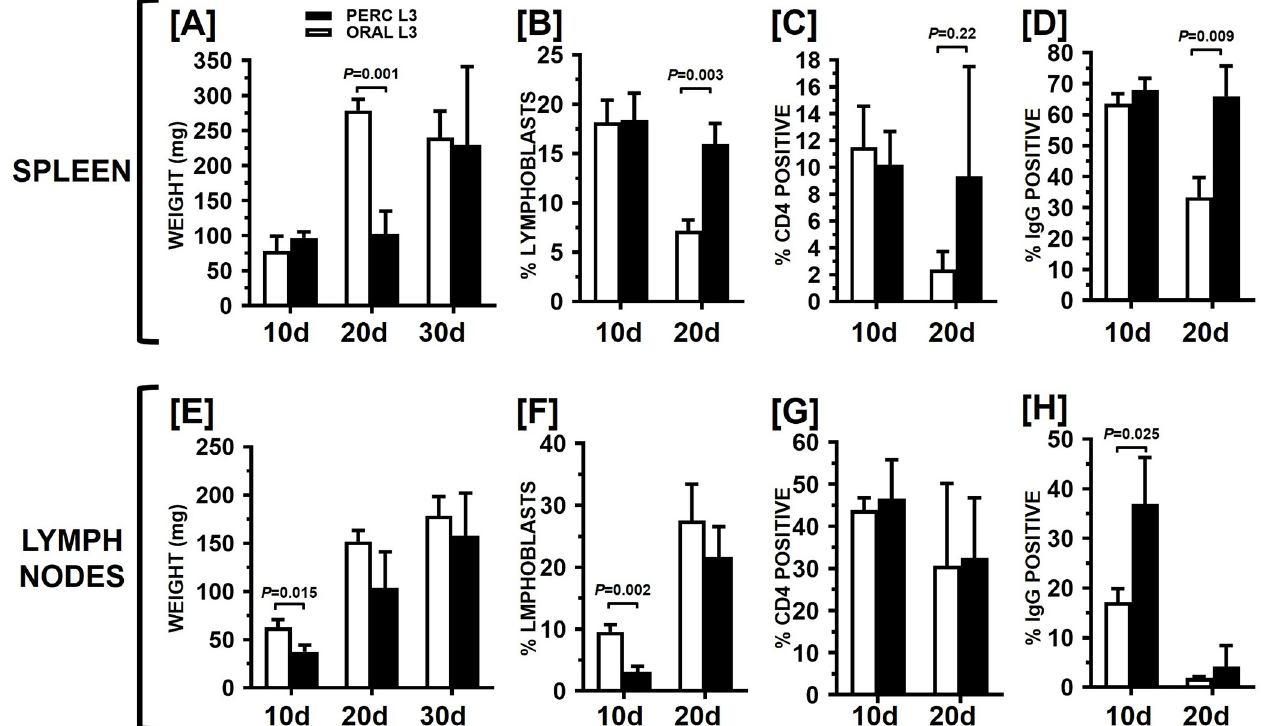
Fig 4. Organ weight and cellular data following percutaneous infection (Experiment 2). Hamsters (n = 9 each group) were infected with 100 L3 by the oral route or 2000 L3 by the percutaneous route. At days indicated, 3 animals from each group were sacrificed and organs recovered, weighed, and lymphocytes analyzed by flow cytometry. For the spleen, mean organ weights are shown in [A], percentage of blasting lymphocytes in [B], percentage of CD4-positive lymphocytes in [C] and percentage of IgG-positive lymphocytes in [D]; the corresponding data for mesenteric lymph nodes is shown in [E-H]. In all panels brackets indicate statistically significant comparisons by Welch t test, with P values given above the brackets. Bars represent Mean values +/- SD.